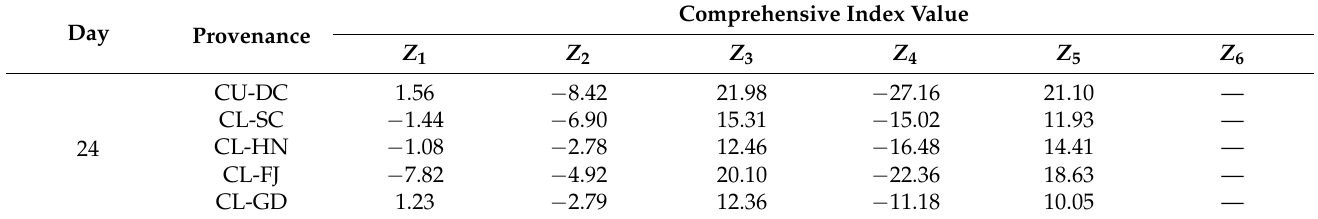
Table 2. Weight of comprehensive index value ( W i ), membership function value,